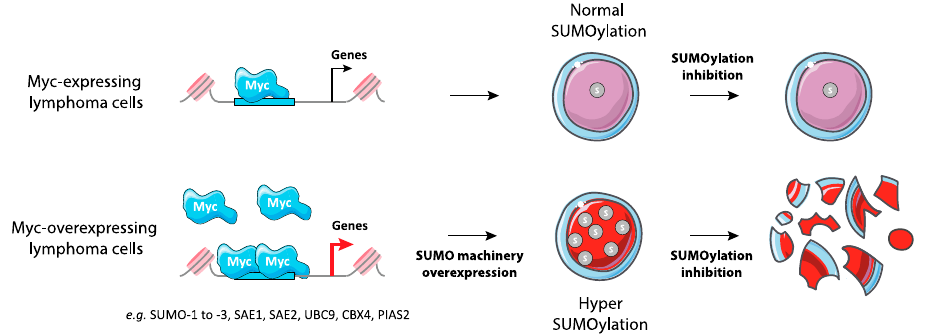
Figure 4. Synthetic lethality between Myc overexpression and inhibition of SUMOylation in lymphoma. Myc-overexpressing B-lymphoma cells show increased expression of many enzymes of SUMOylation enzymes and global hyperSUMOylation. These cells are highly sensitive to the inhibition of SUMOylation.